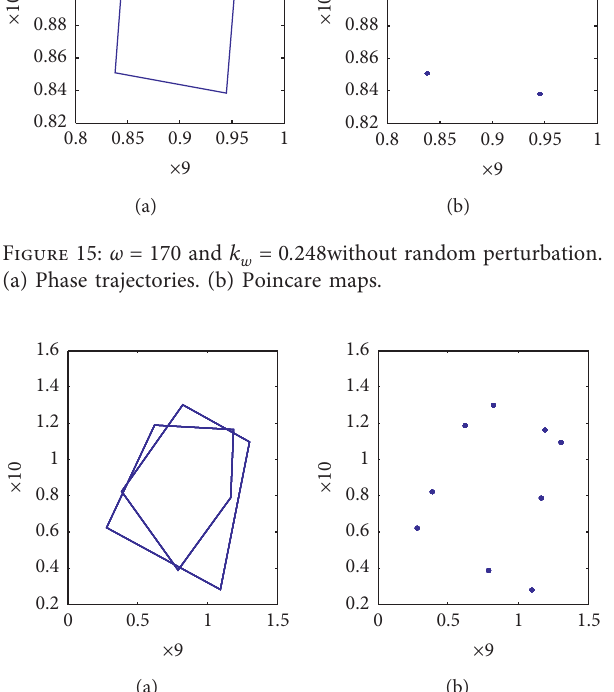
Figure 16: ω � 192 and k � 0 . 248 without random perturbation. w (a) Phase trajectories. (b) Poincare maps.